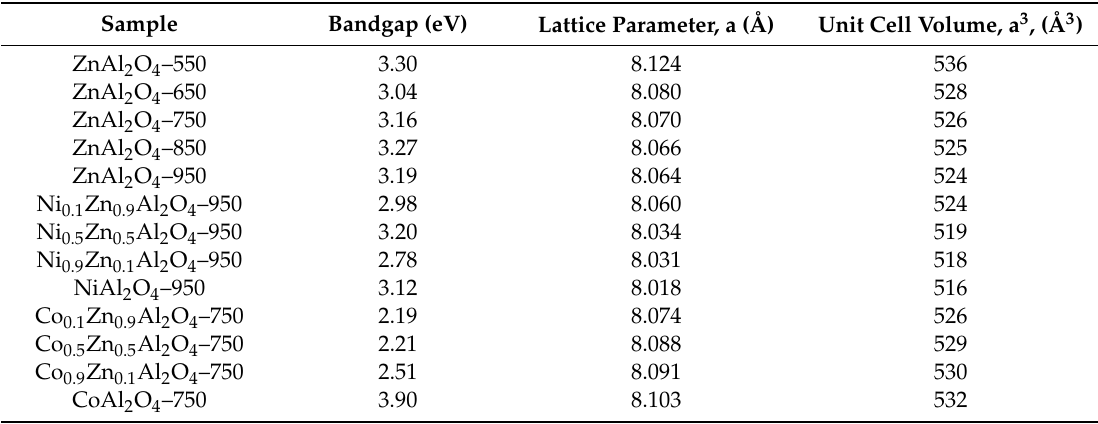
Table 1. Bandgap, lattice parameter and unit cell volume for samples Zn 1 − x M x Al 2 O 4 . Sample Bandgap